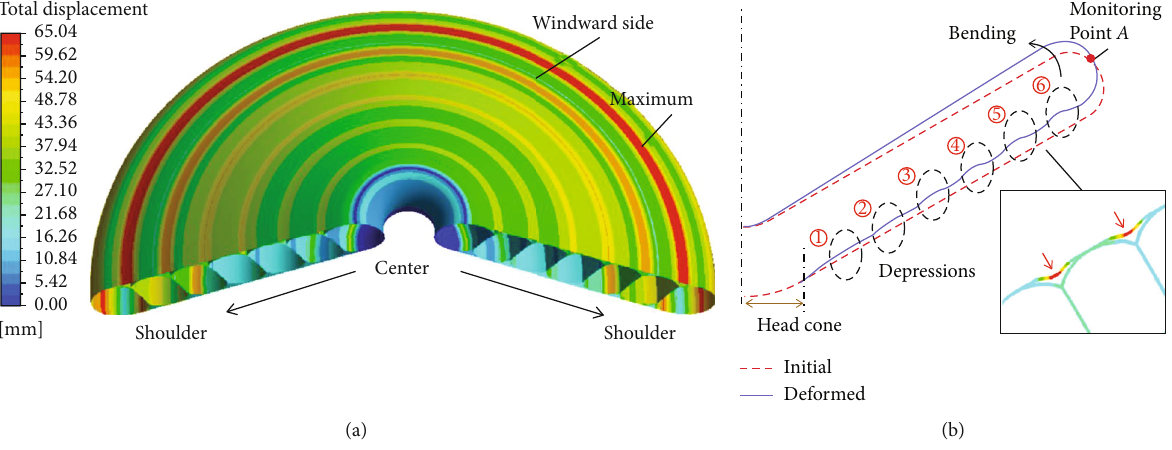
Figure 16: Structural deformation: (a) nephogram; (b) meridian pro fi